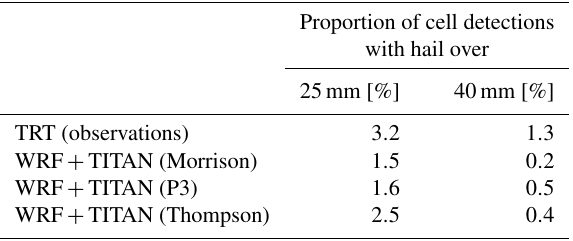
Table 7. Proportions of total cell detections that contained hail with estimated diameter greater than 25mm or 40mm for observations and simulation